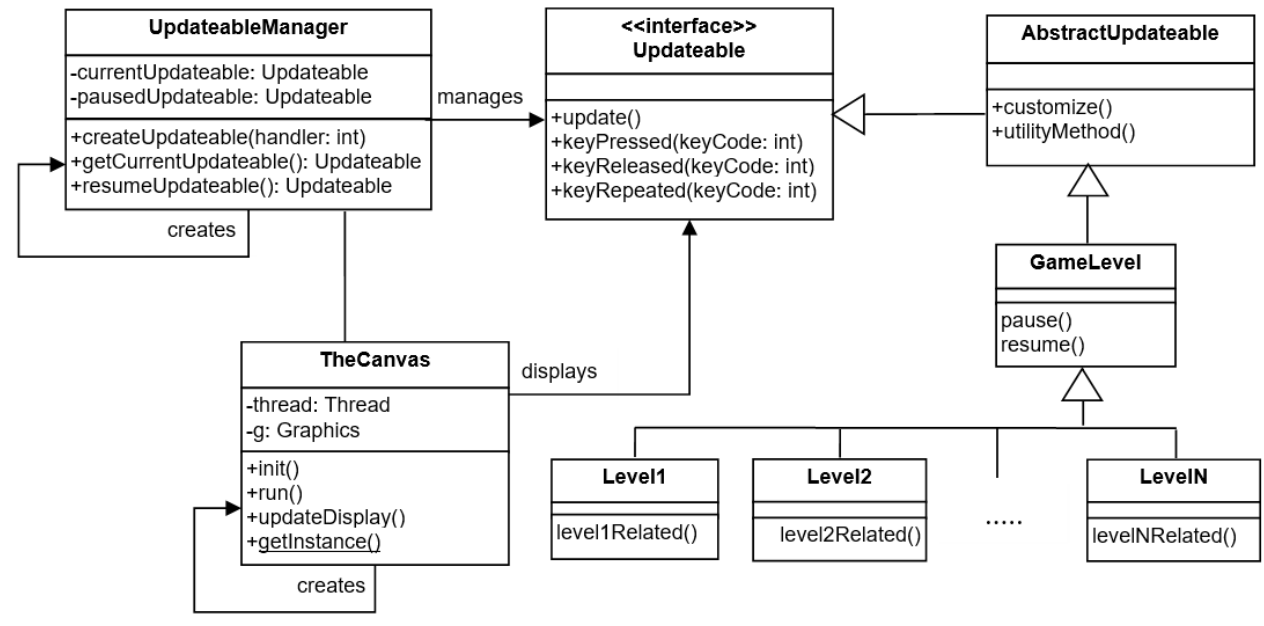
Figure 11. Unrelated Level